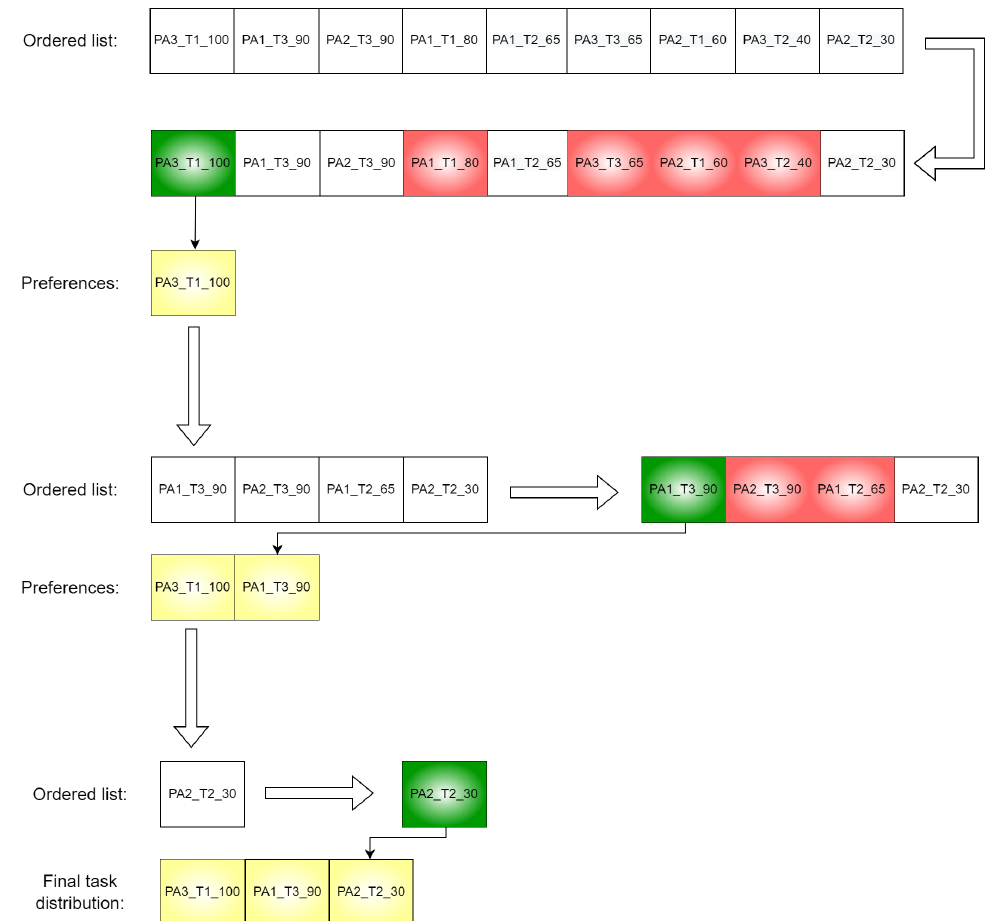
Figure 6. The second step of the agents preferences distribution strategy.